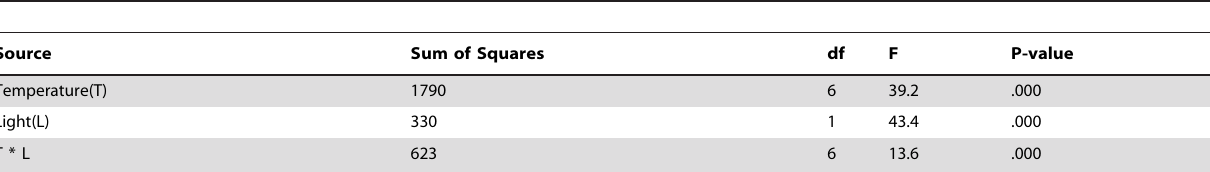
Table 1. Two way ANOVA of the effects of temperature, light and their interaction on germination of fresh seeds of Stipa bungeana (n=4).